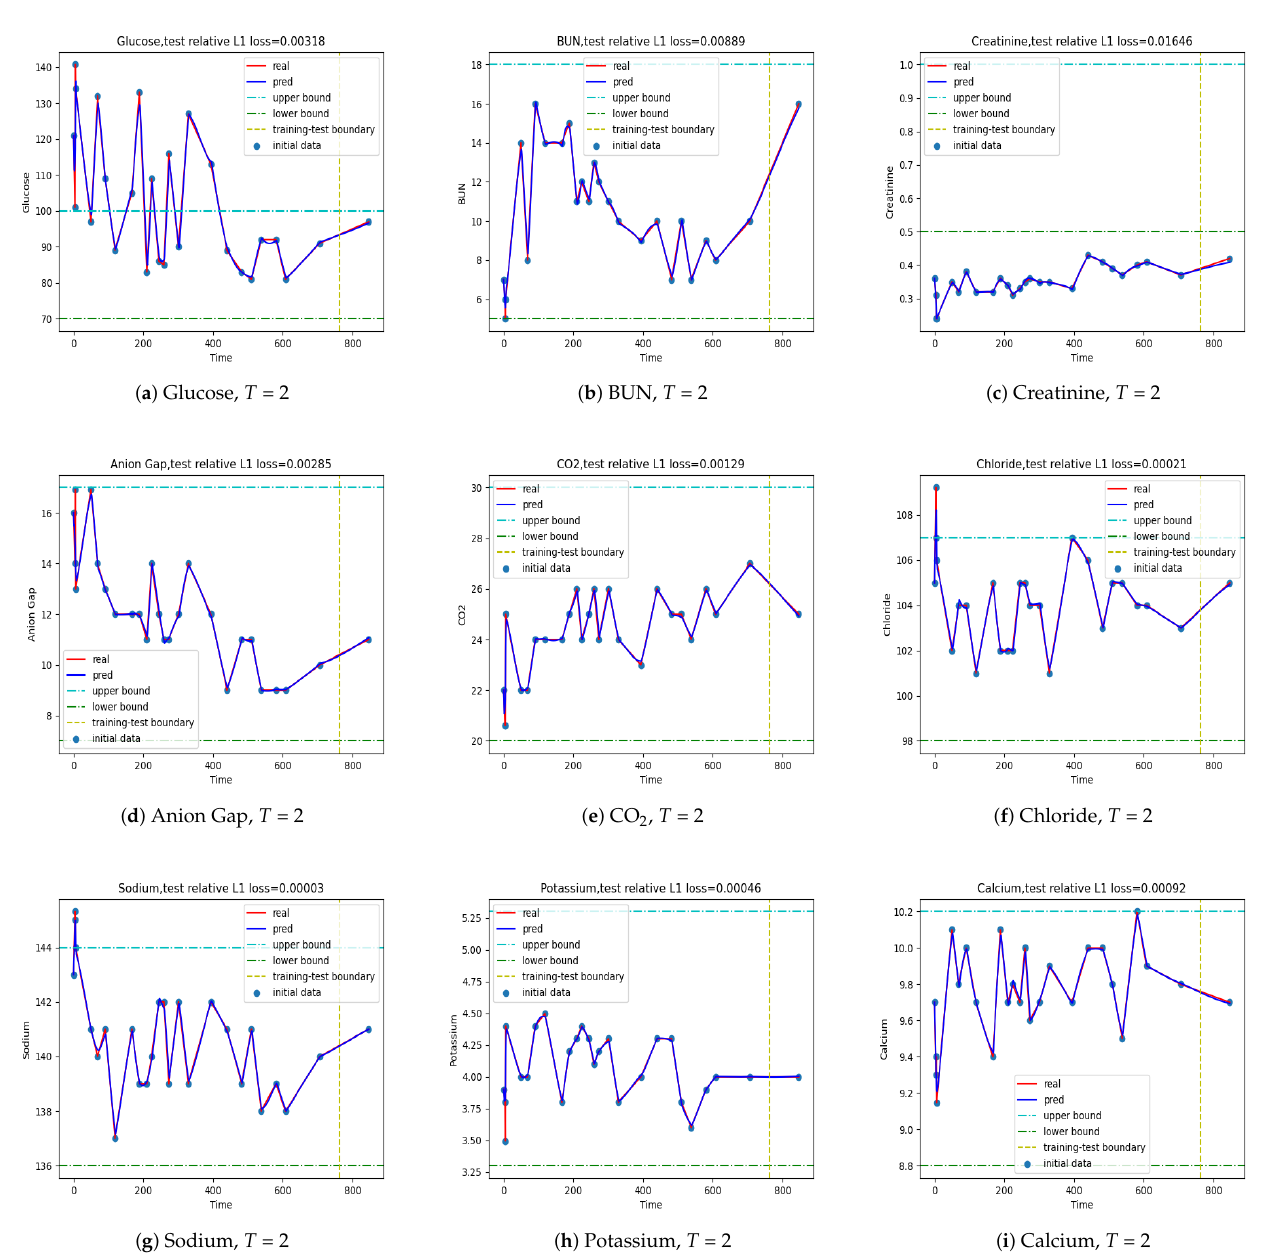
Figure A3. The one-step prediction of the LSTM model for patient SCC with time step T =